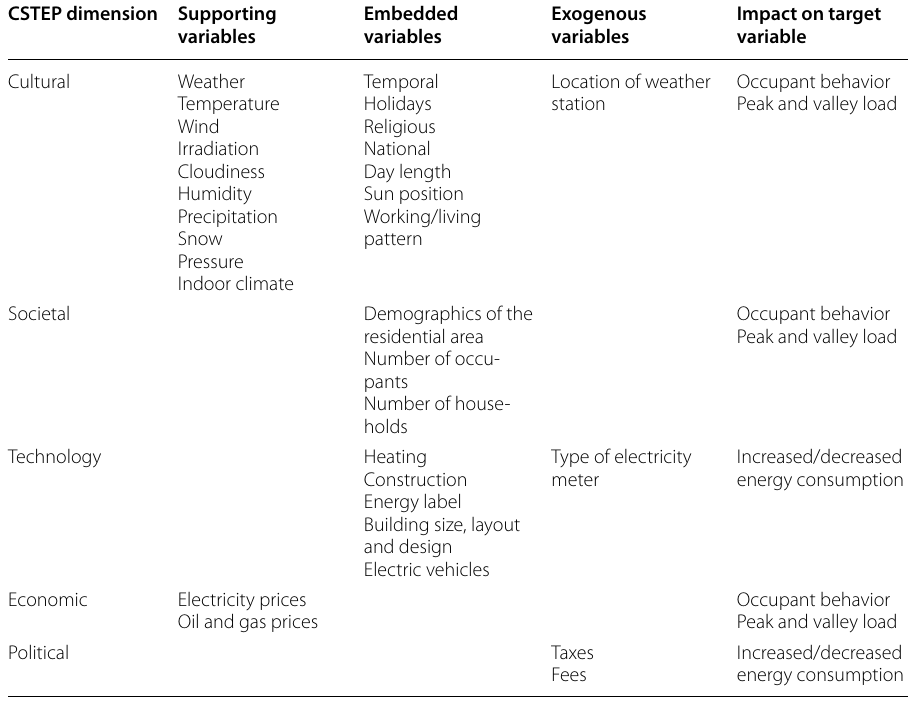
Table 1 Systematically identified CSTEP variables CSTEP dimension Supporting